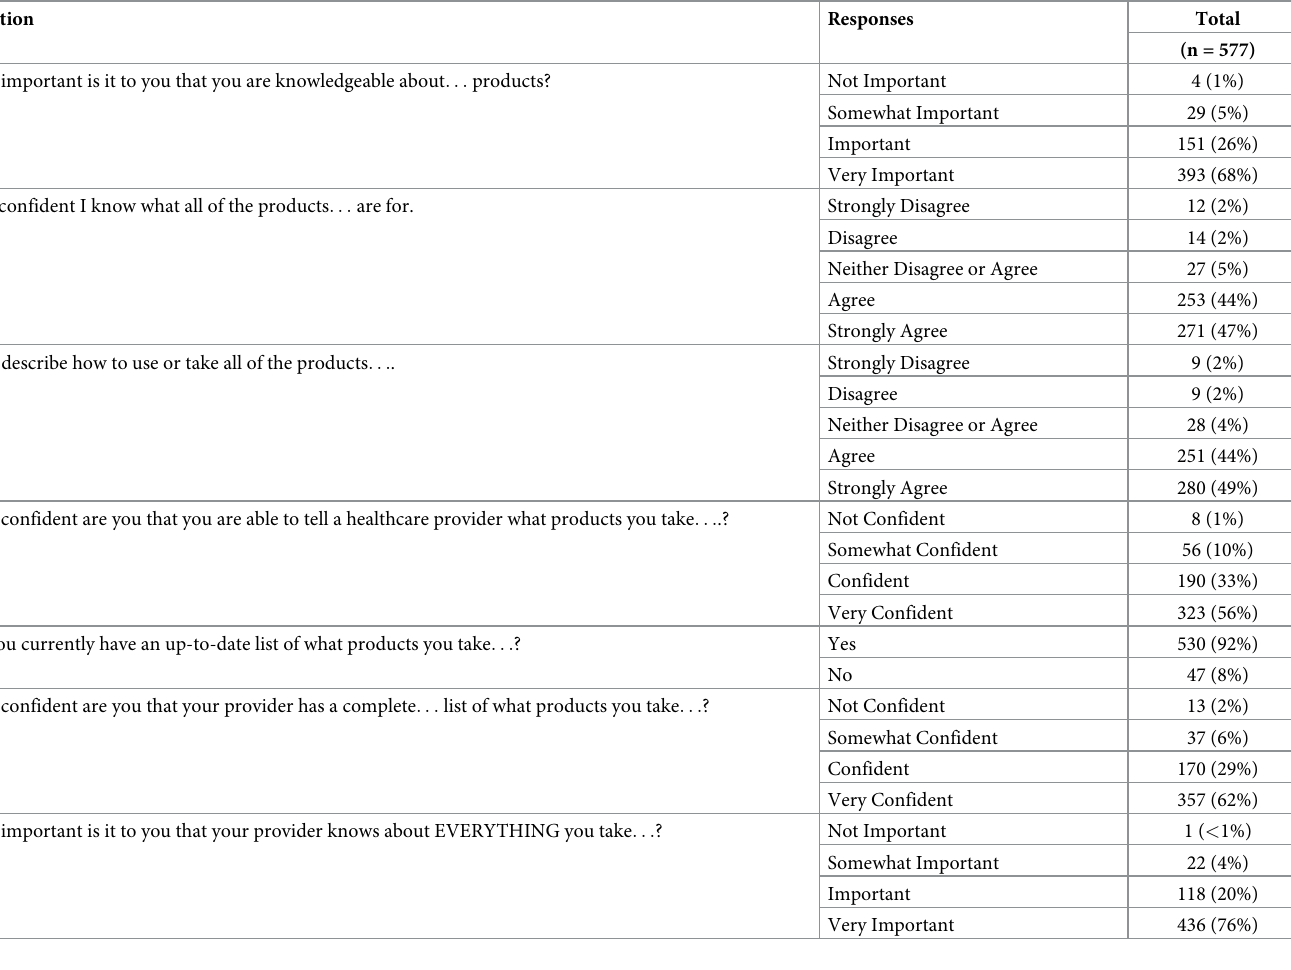
Table 6. Patient survey